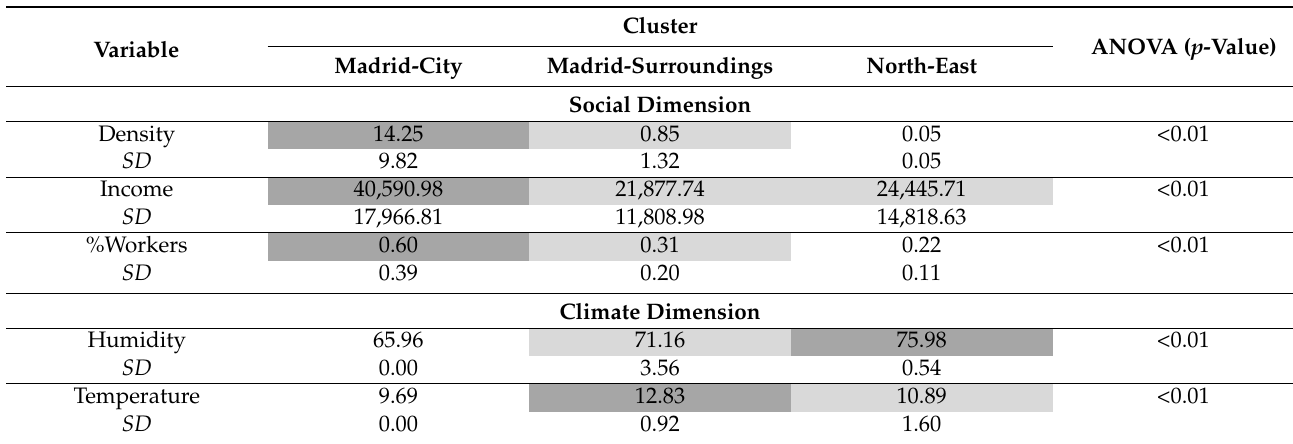
differences between two groups, only dark gray and light gray are used to distinguish the groups. Differences in means were tested by Scheff é ´ s methods at a significance level of 0.05.